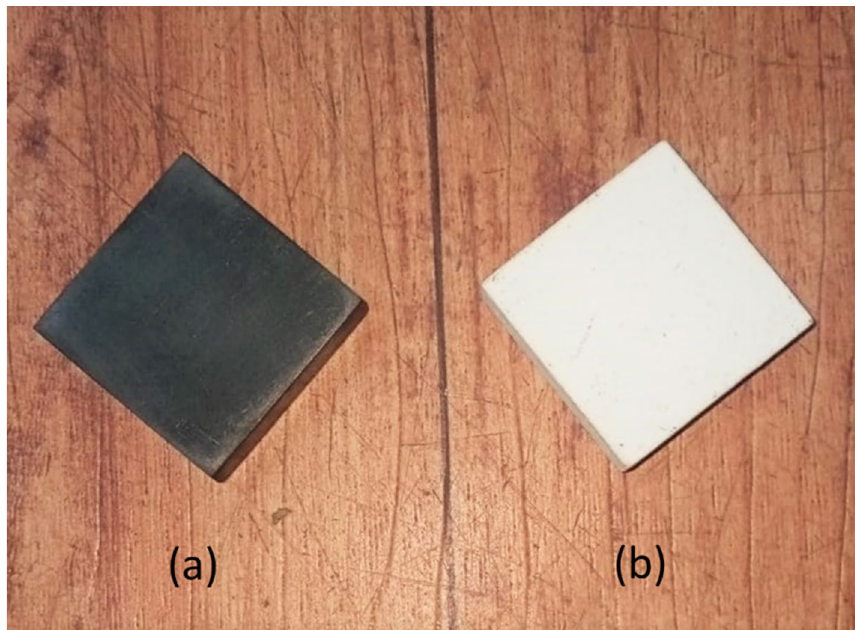
Figure 2. Picture of ( a ) ‘bare graphite’ and ( b ) ‘coated